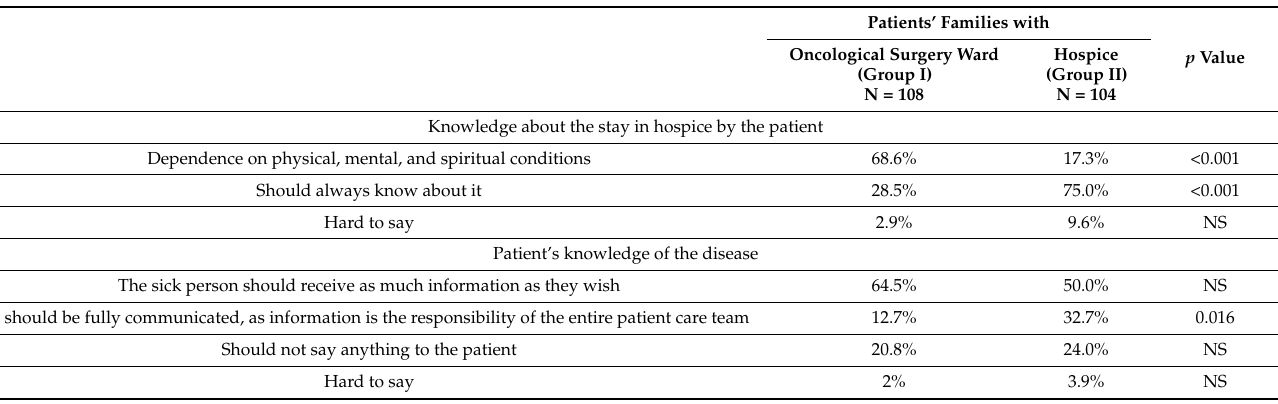
Table 7. The respondents’ opinions on the need to inform the patient that he/she is in a hospice as well as about